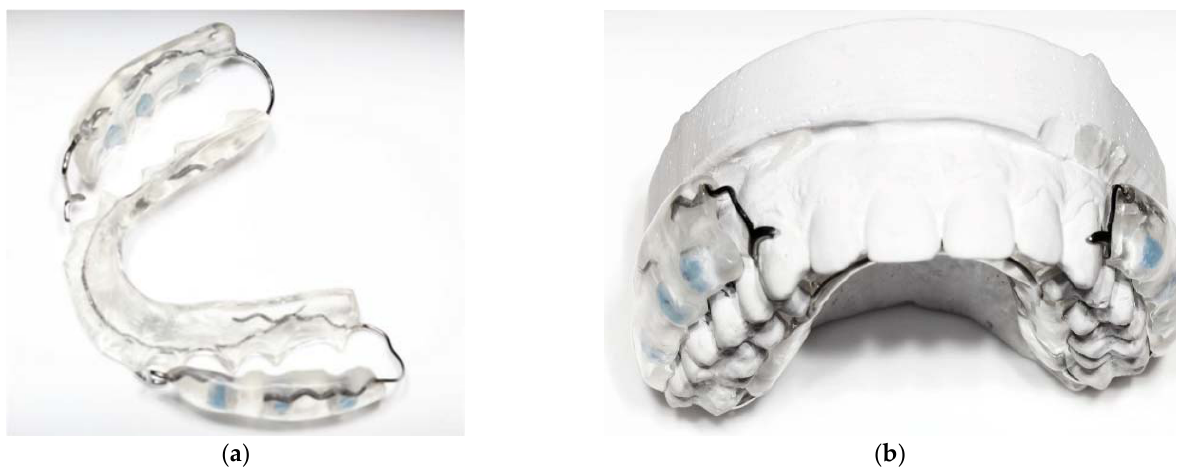
Figure 1. Custom ‐ made removable acrylic splint: ( a ) specimens facing towards the buccal side of the first three approximal spaces of the posterior teeth; ( b ) placed onto a dental cast with the outward shielding element towards the cheeks and free space between the specimens and teeth, allowing salivatory flow.